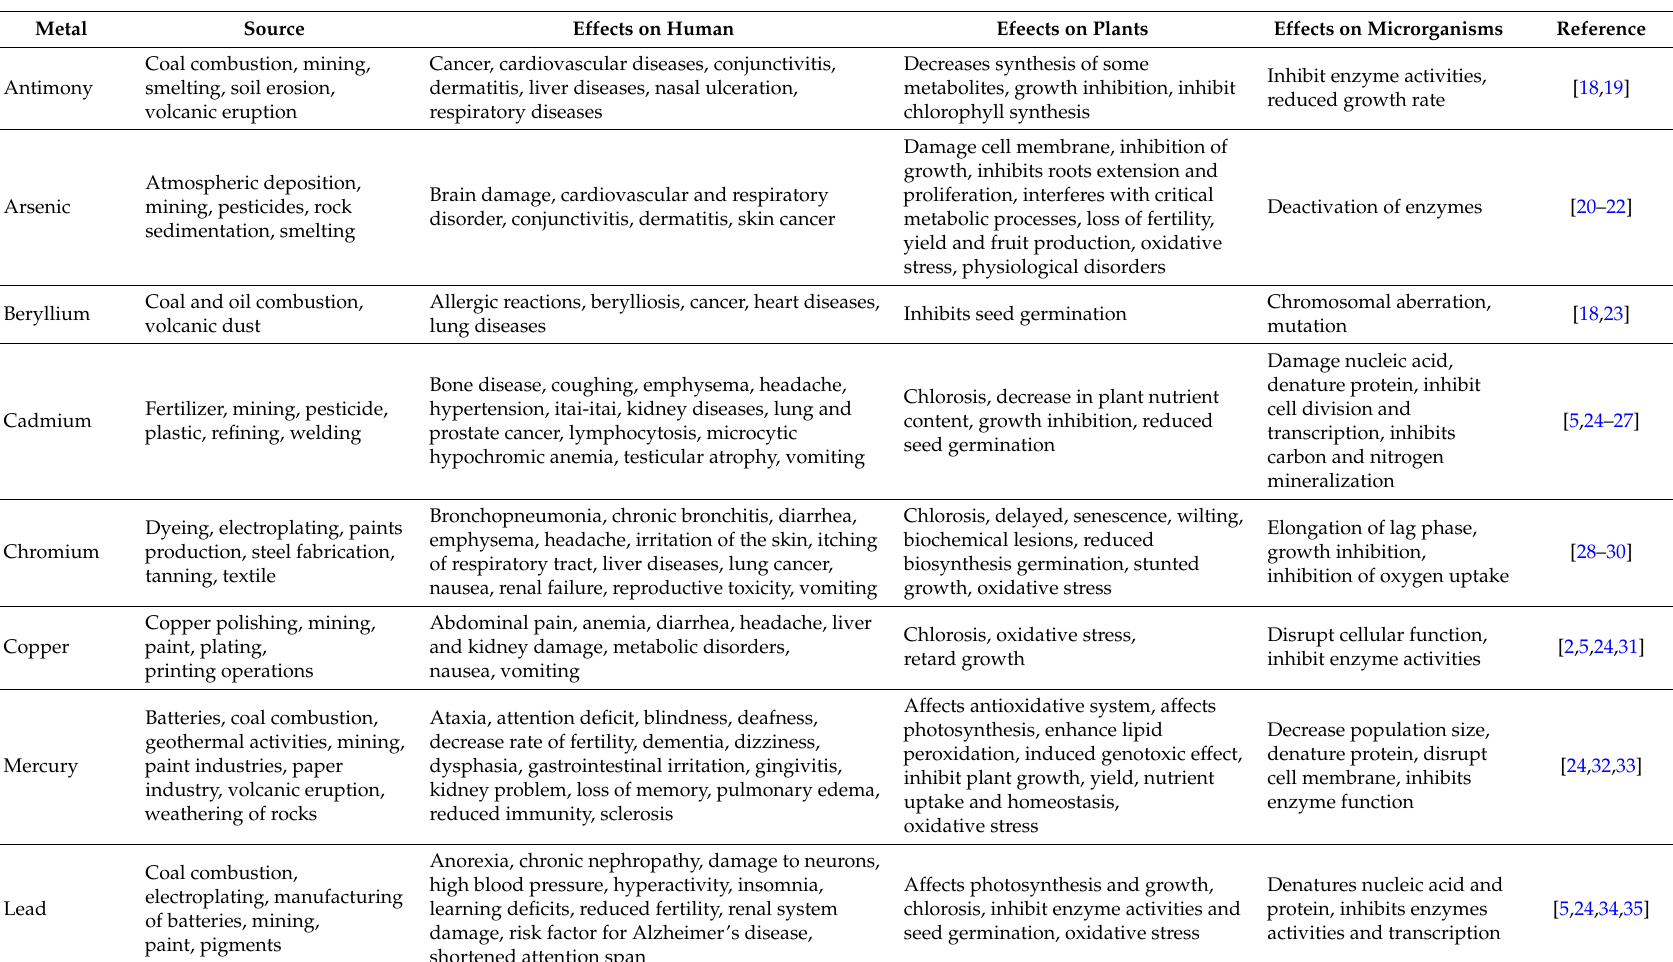
Table 1. Toxicity of heavy metals to life